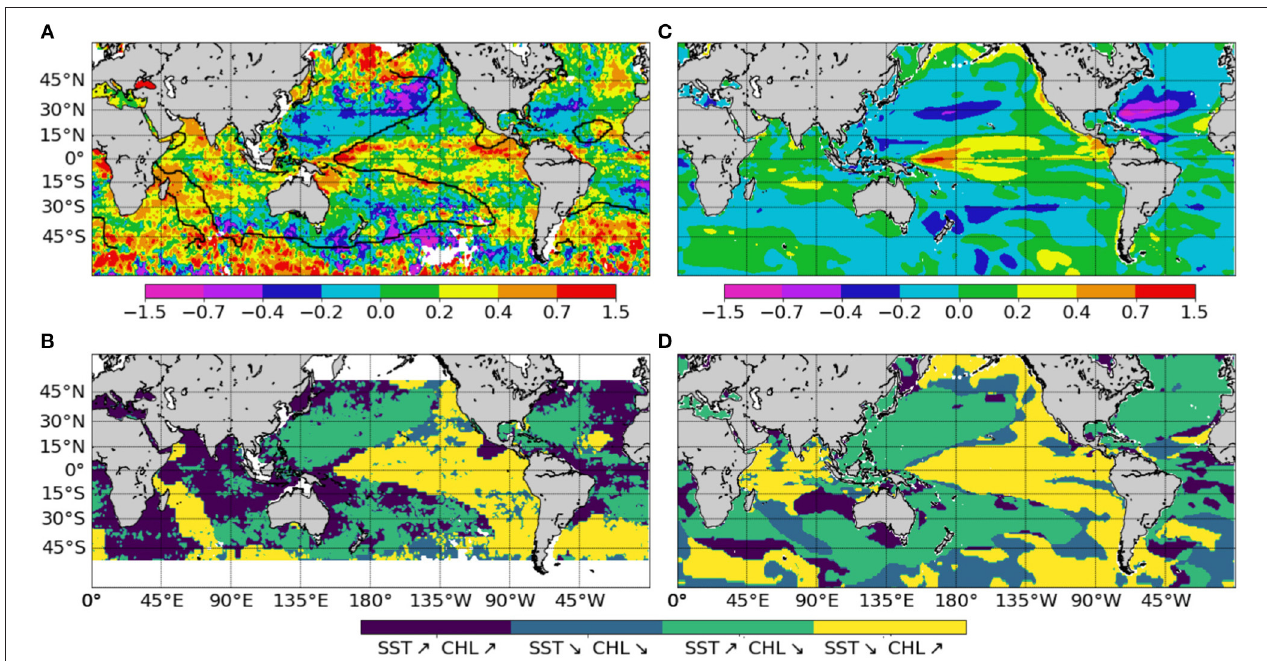
FIGURE 11 | Chl change from the CZCS (1979–1983) to the SeaWiFS (1998–2002) era, expressed as the logarithm of the ratio of the average values over the two time periods (A) from satellite Chl adapted from Antoine et al. (2005), (C) from Chl Svr − CCI . Note that this ratio is multiplied by 2 to fit the same color bar as in (A) . Maps of areas with concomitant parallel or opposite changes of Chl and SST (B) from Chl satellite and SST from the SODA reanalysis adapted from Martinez et al. (2009) and (D) from Chl Svr − CCI and SST NEMO . The respective SST zero differences are shown on the maps as a thick black